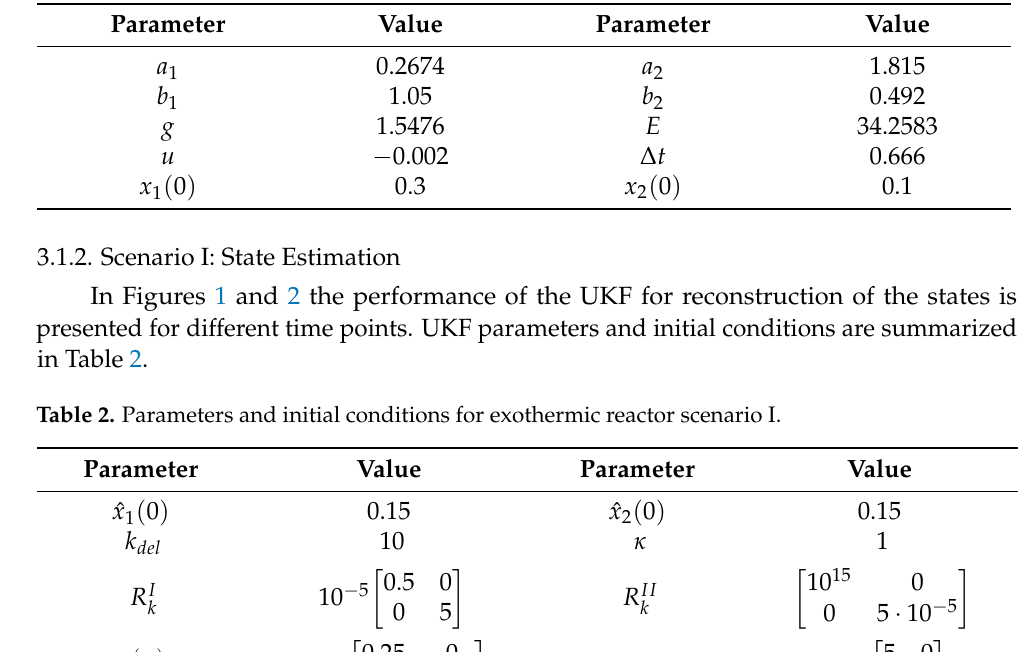
Table 1. Parameter values for nonlinear reactor model.